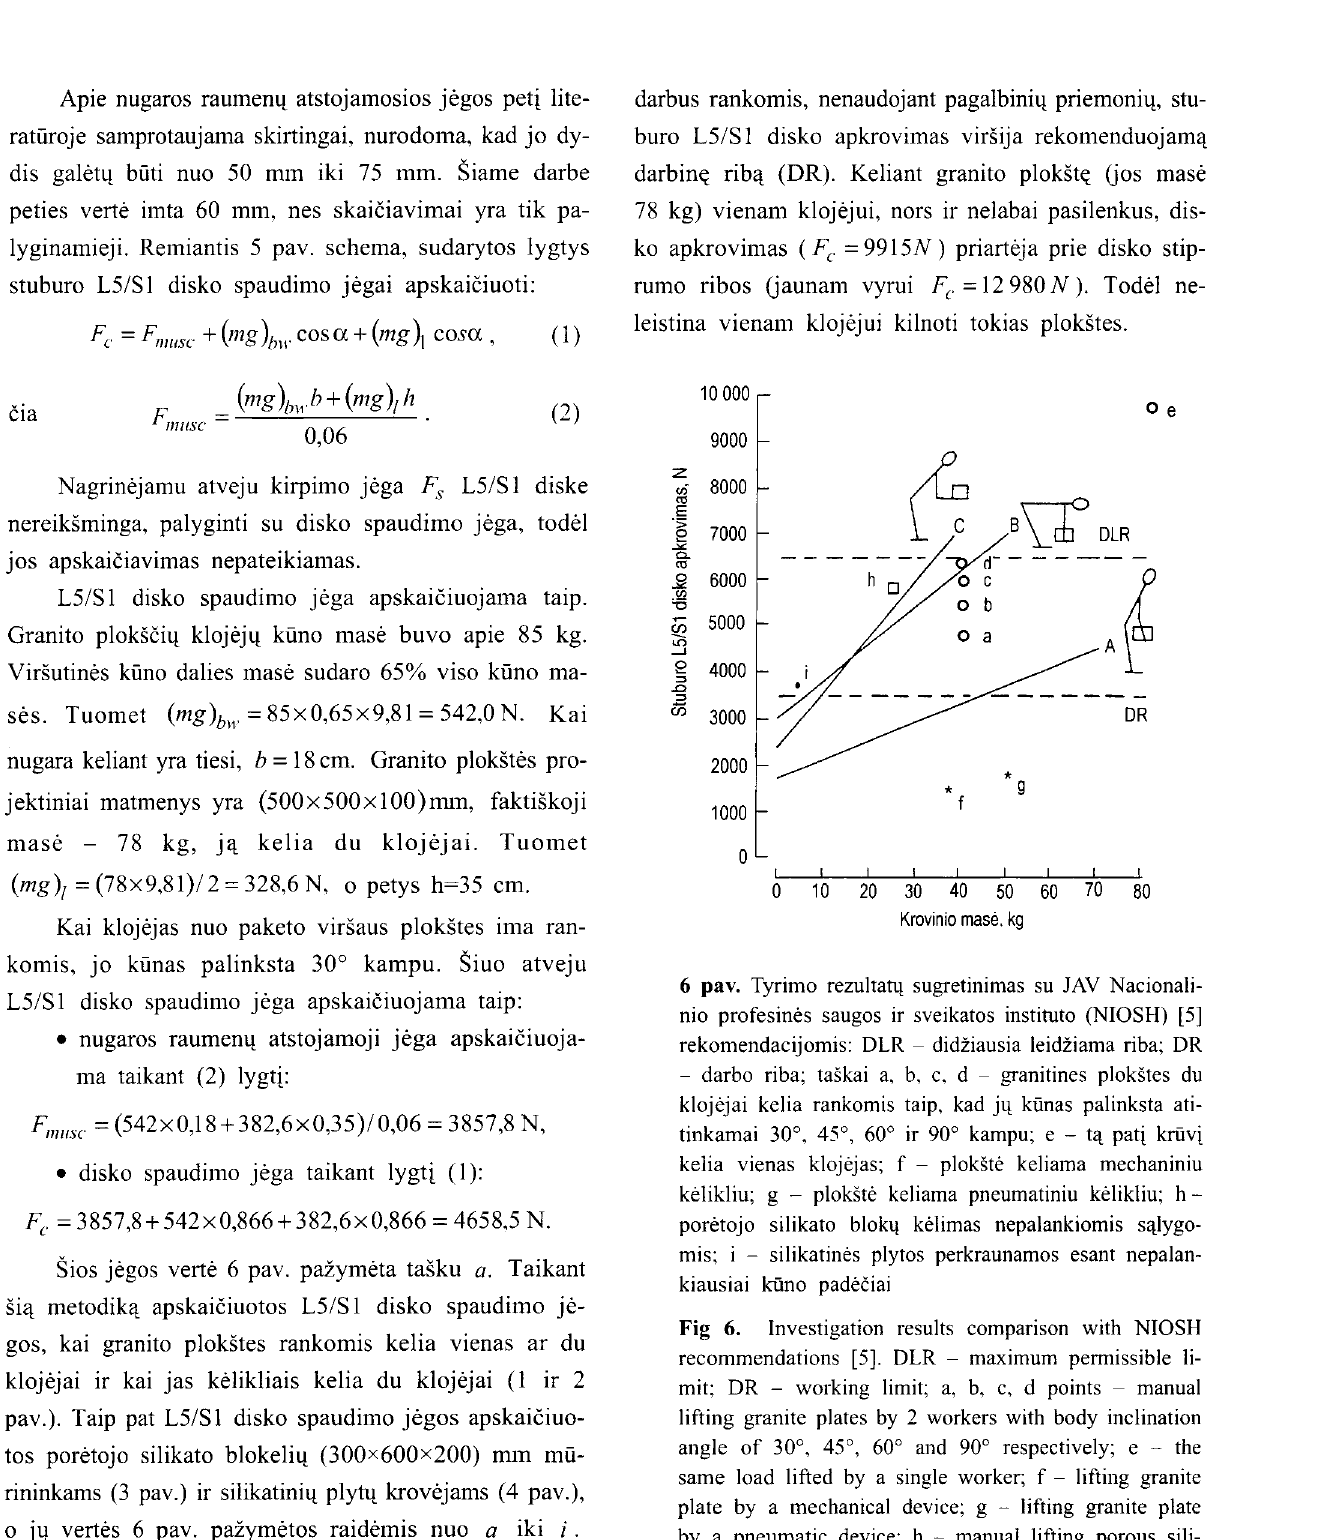
Fig 6. Investigation results comparison with NIOSH recommendations [5]. DLR - maximum permissible